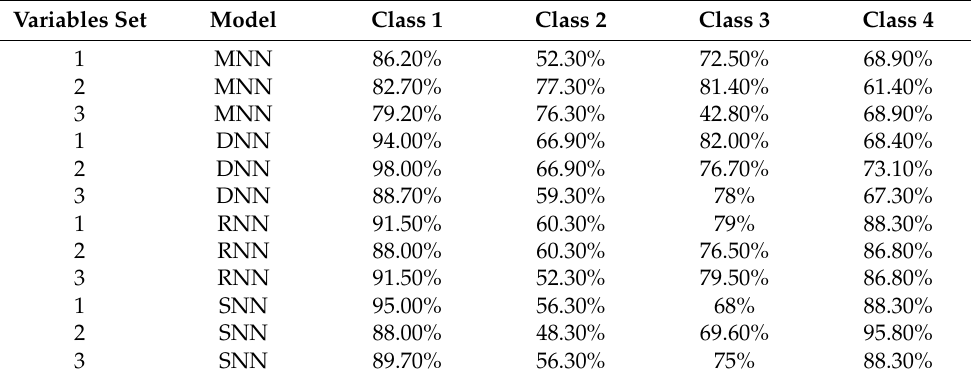
Table 10. Outcomes of the sensitivity analysis of the used